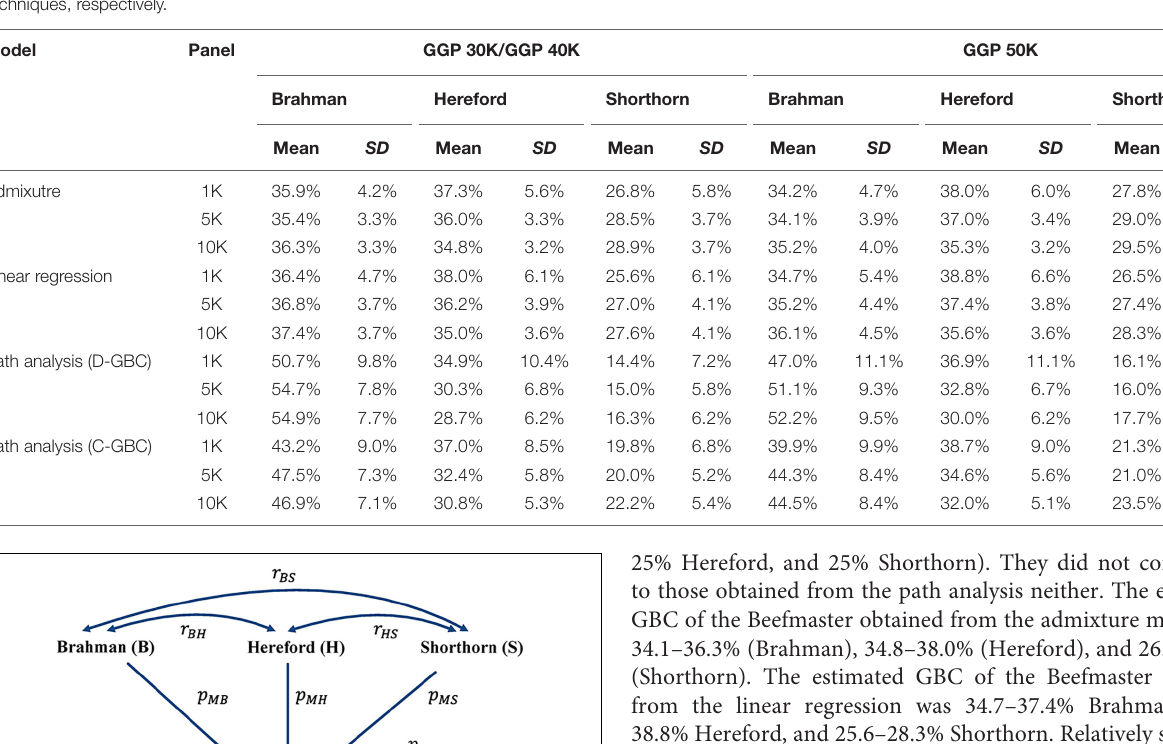
Correlation with Beefmaster